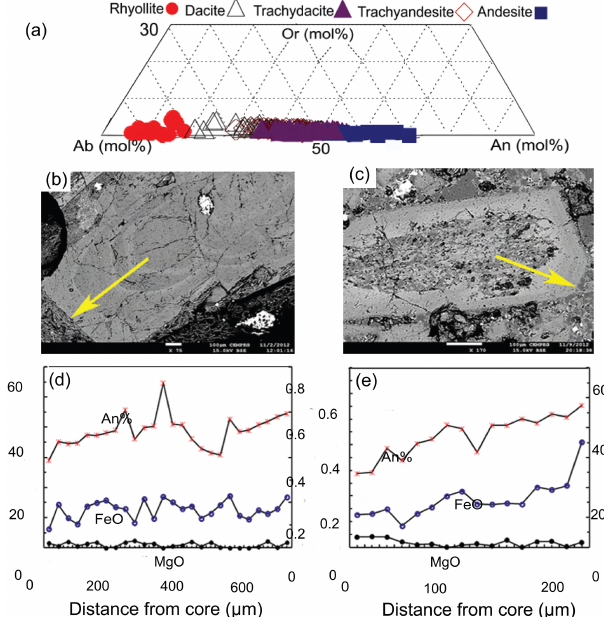
( n = 212) in the feldspars composition triangle. Plagioclase com- position in the samples of the northern sector vary between An 20 and An 70 . Plagioclase in rhyolites from the south part range from An 20 to An 8 . The BSE images of selected plagioclase phenocrysts show (b) oscillatory-zoned plagioclase with an abrupt increase in An contents (up to 15mol%) toward the rim and (c) sieve-textured plagioclase mantled by high An rim. (d) and (e) Zoning profiles showing variations in X An and MgO and FeO for the oscillatory- zoned plagioclase and the sieve-textured plagioclase in (b) and (c) , respectively. Yellow arrows indicate core to rim profile.